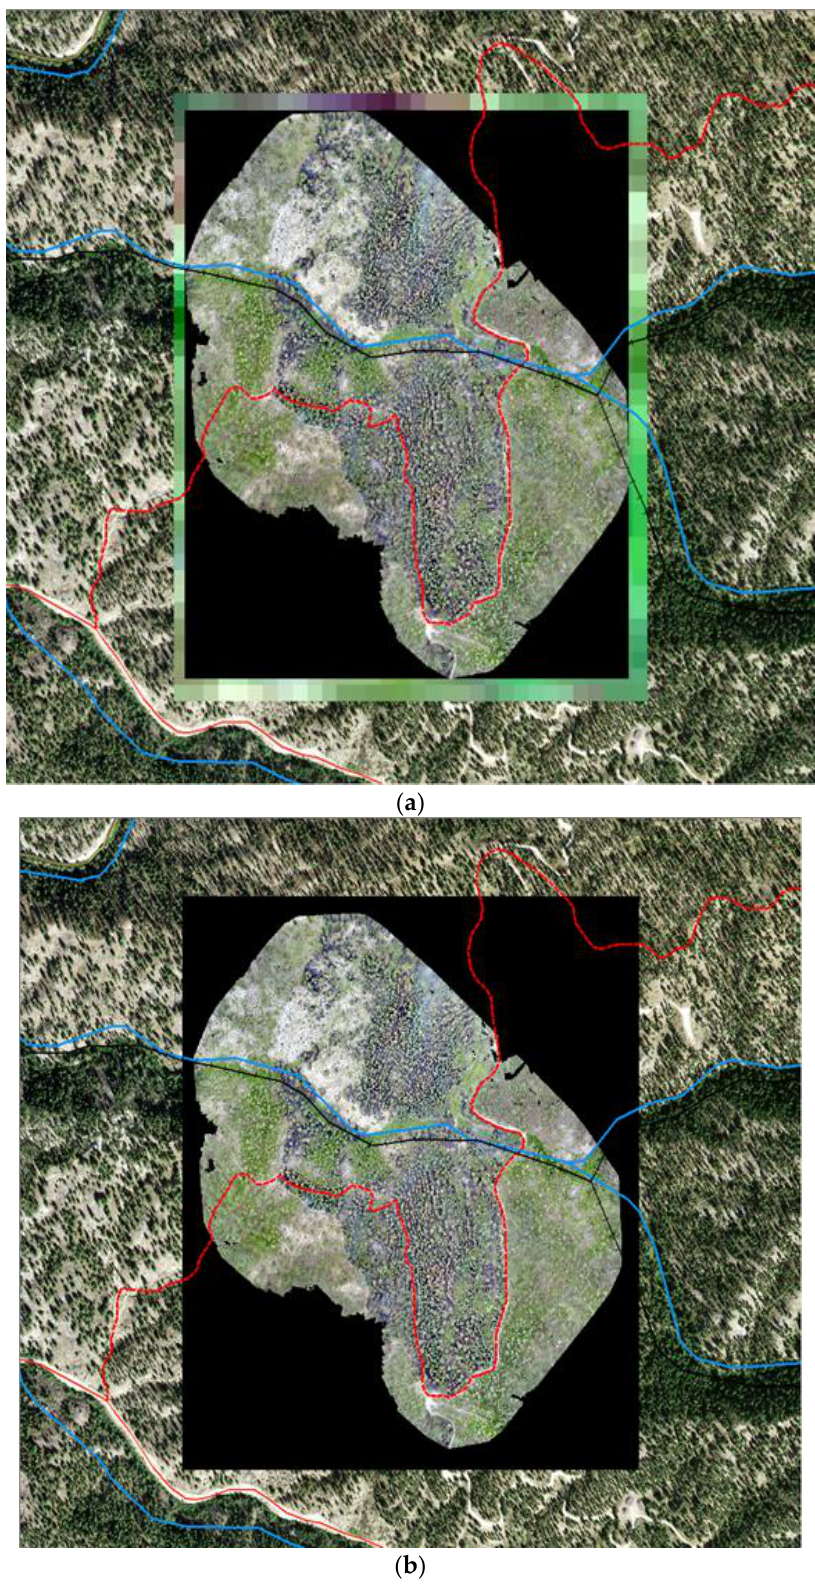
Figure 9. ( a ) sUAS orthomosaic rendered on top of clipped Landsat image; ( b ) sUAS orthomosaic with a buffer of null pixels giving it the same extent as the clipped Landsat image. Red polylines represent roads and trails. Blue polylines represent creeks. Black hatched polyline represents a historic railgrade.